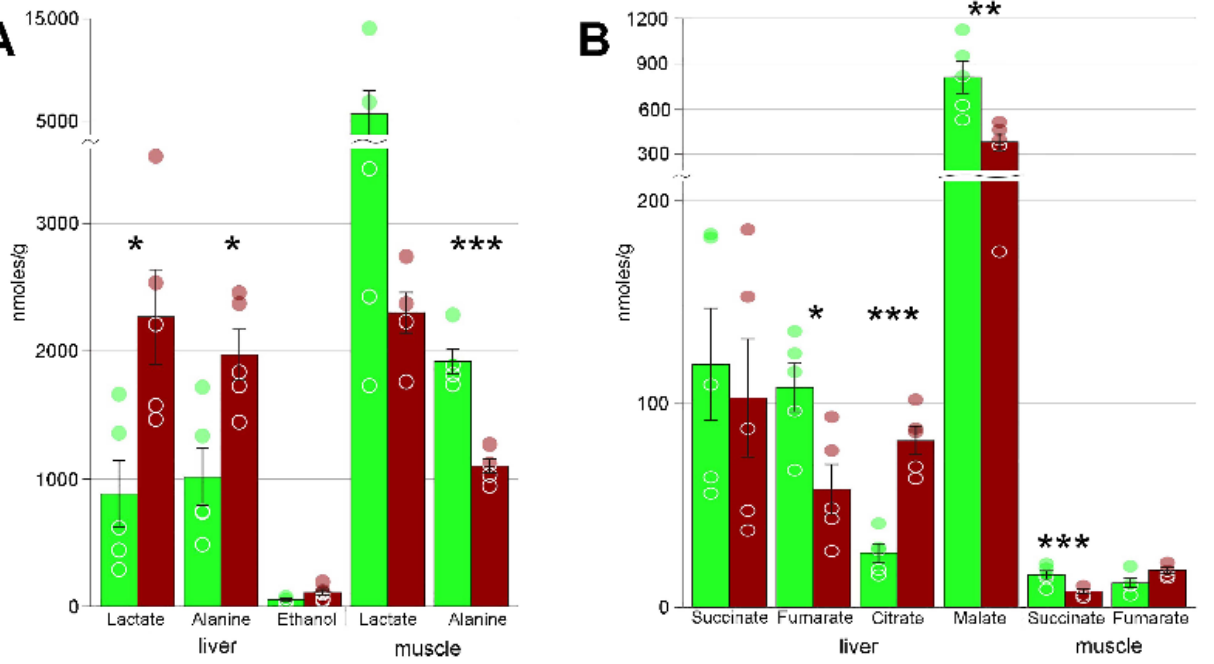
Figure 4. ( A ) concentrations of glycolysis end products; ( B ) Krebs cycle intermediates. Green columns, control; red, frozen; * Welch test p < 0.05; ** p < 0.01; *** p < 0.001; circles, individual data points; bar, SE.